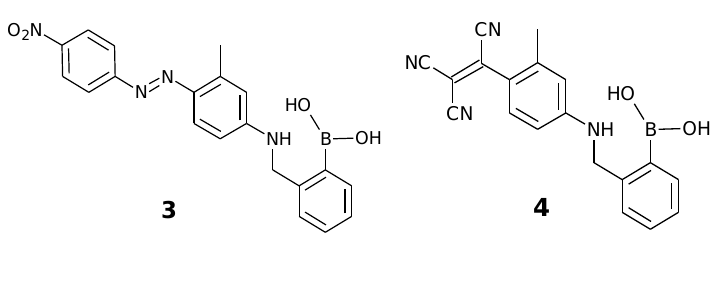
Figure 3. Chemical structures of dye 3 and 4